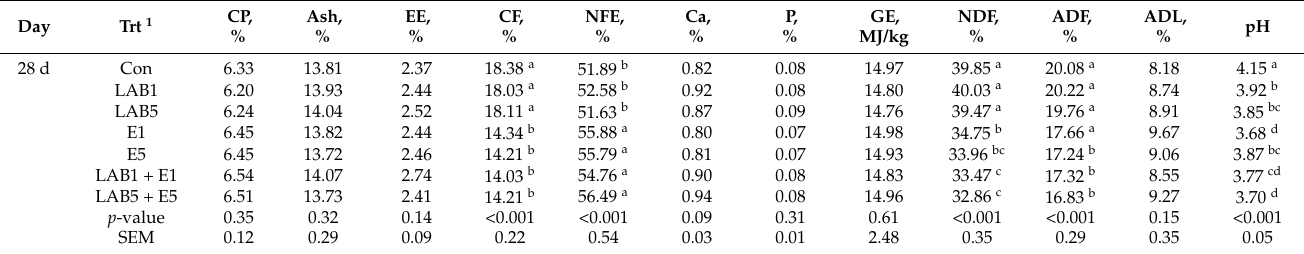
Table 4. Nutrient composition and pH of citric acid by-product at 28 days of fermentation.